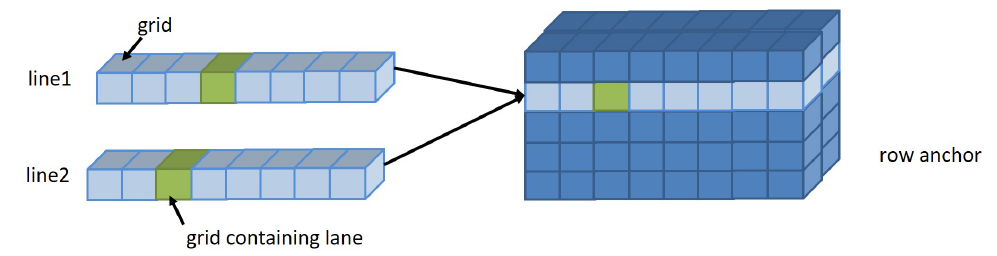
Figure 5. Schematic diagram of row anchor. The light blue blocks represent a grid cell in the selected row anchor. Green blocks indicate that this grid contains the corresponding lanes. Dark blue blocks represent grid cells from the remaining row anchors. The height of the cube on the right represents the number of row anchors, denoted as h . Furthermore, the width of this cube represents the number of grid cells, denoted as w